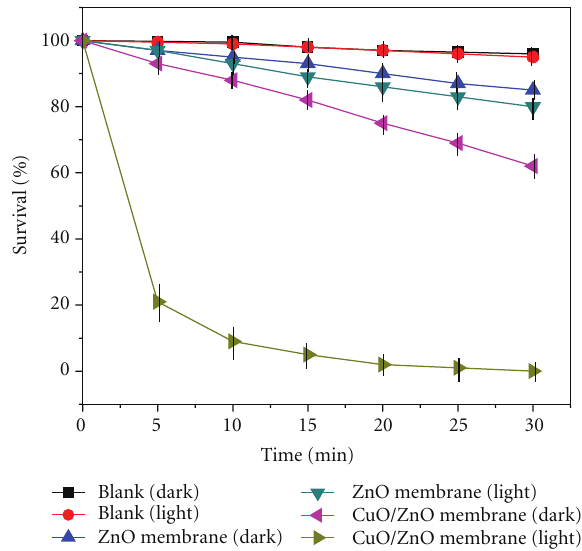
Figure 10: Plot of % E . coli survival rate as the function of visible light irradiation time on CuO/ZnO membrane and ZnO